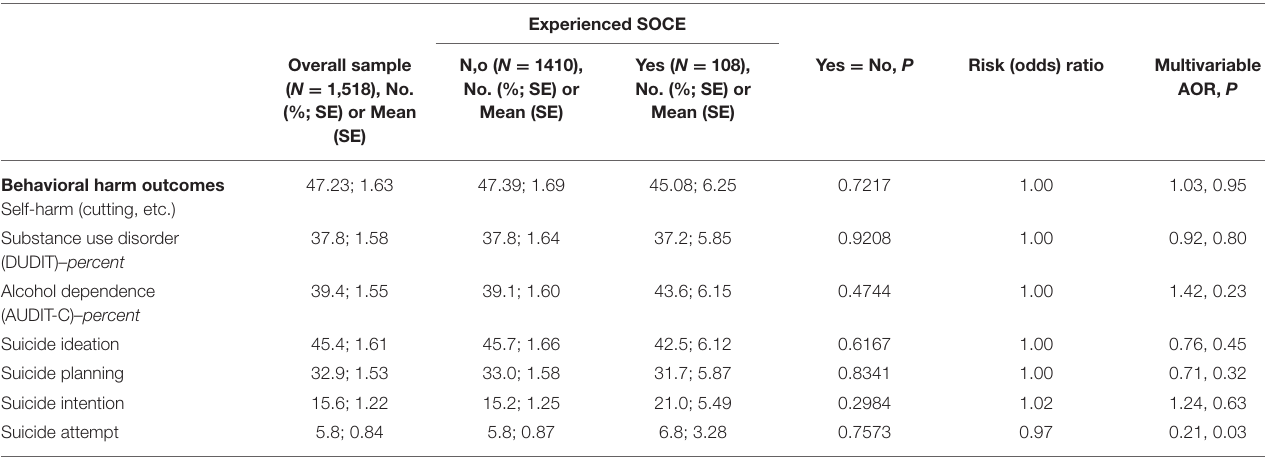
TABLE 3 | Unadjusted means and risk ratios, and adjusted AORs, showing current behavioral harm by experiencing SOCE, counts, and weighted proportions: probability sample of sexual minorities, United States, 2016–2018 ( N = 1,518).